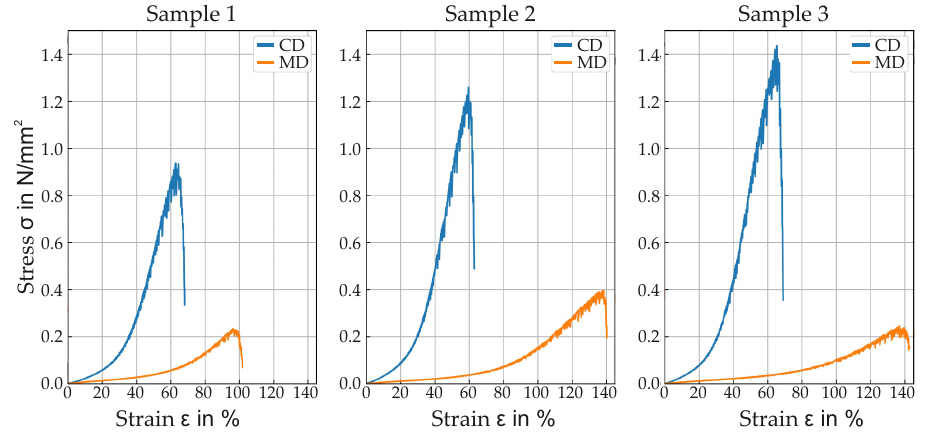
Figure 2. Strain-stress curves for all samples obtained from tensile test Table 1. Experimental measurements of the material properties of the